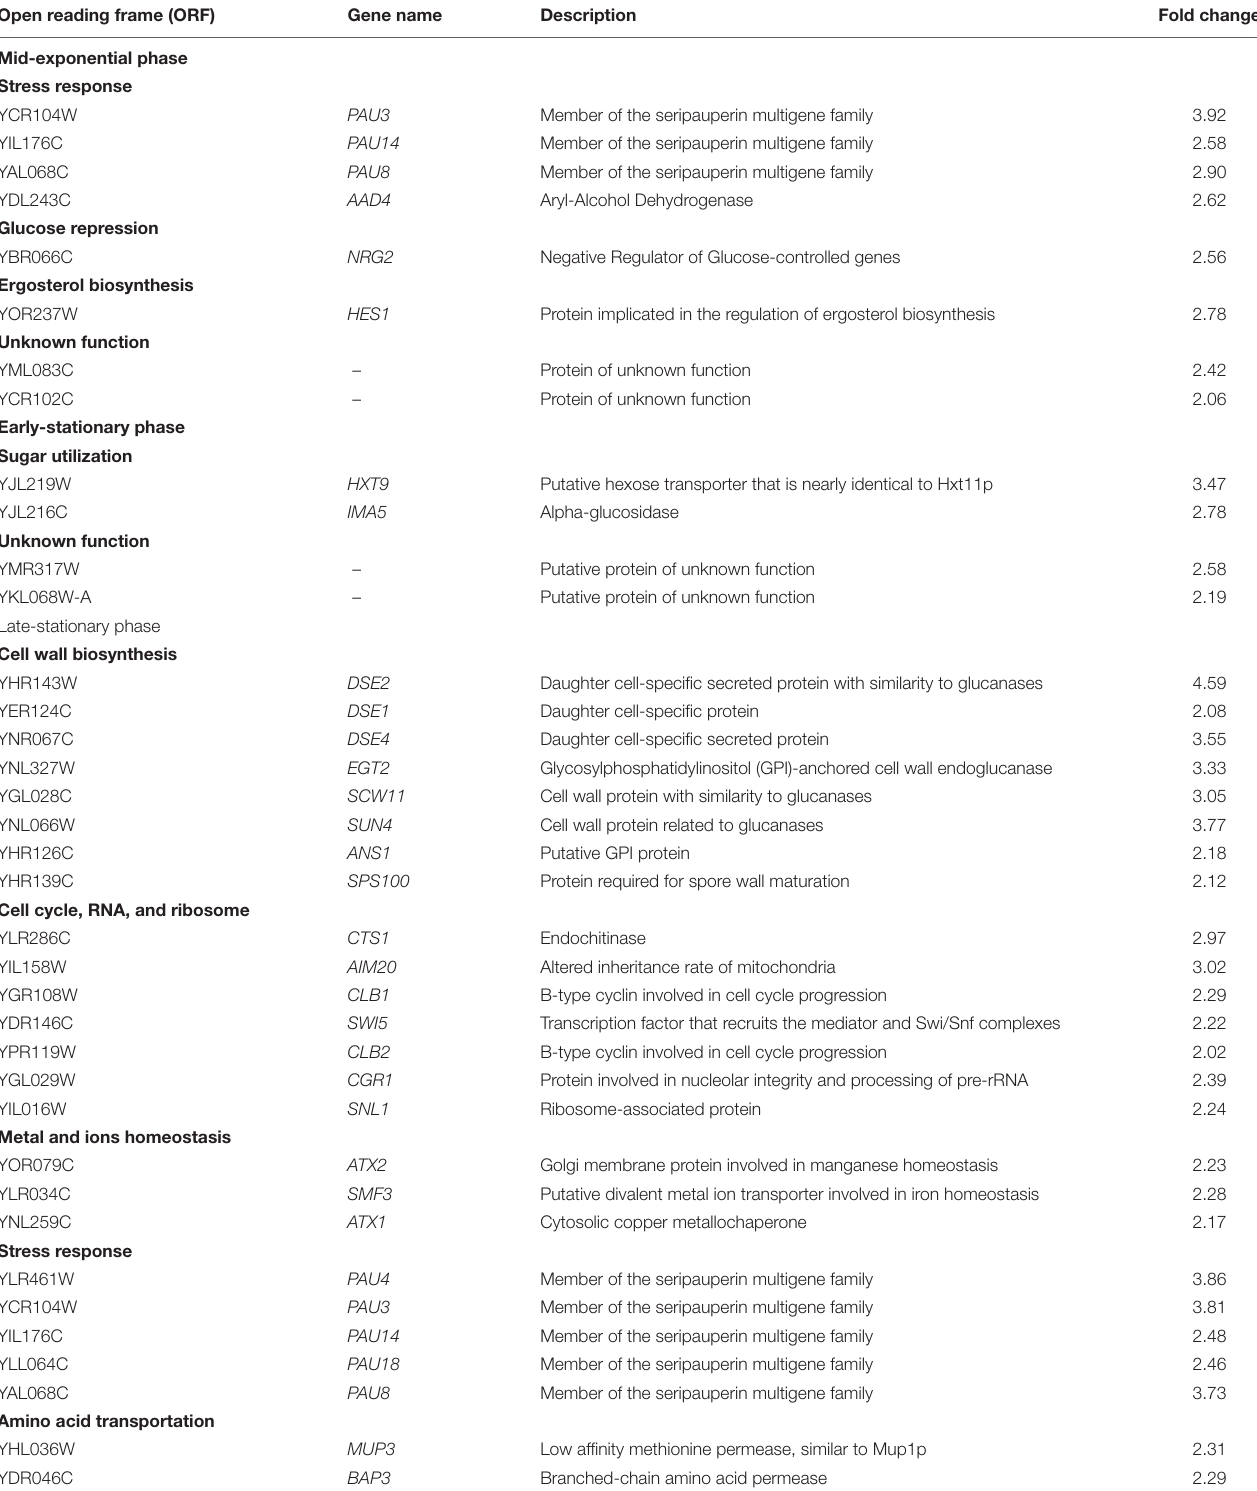
TABLE 2 | Genes upregulated in MS300 media with high vs. low concentrations of UFAs, in different stages of yeast growth categorized by biological process (double or more). Open reading frame